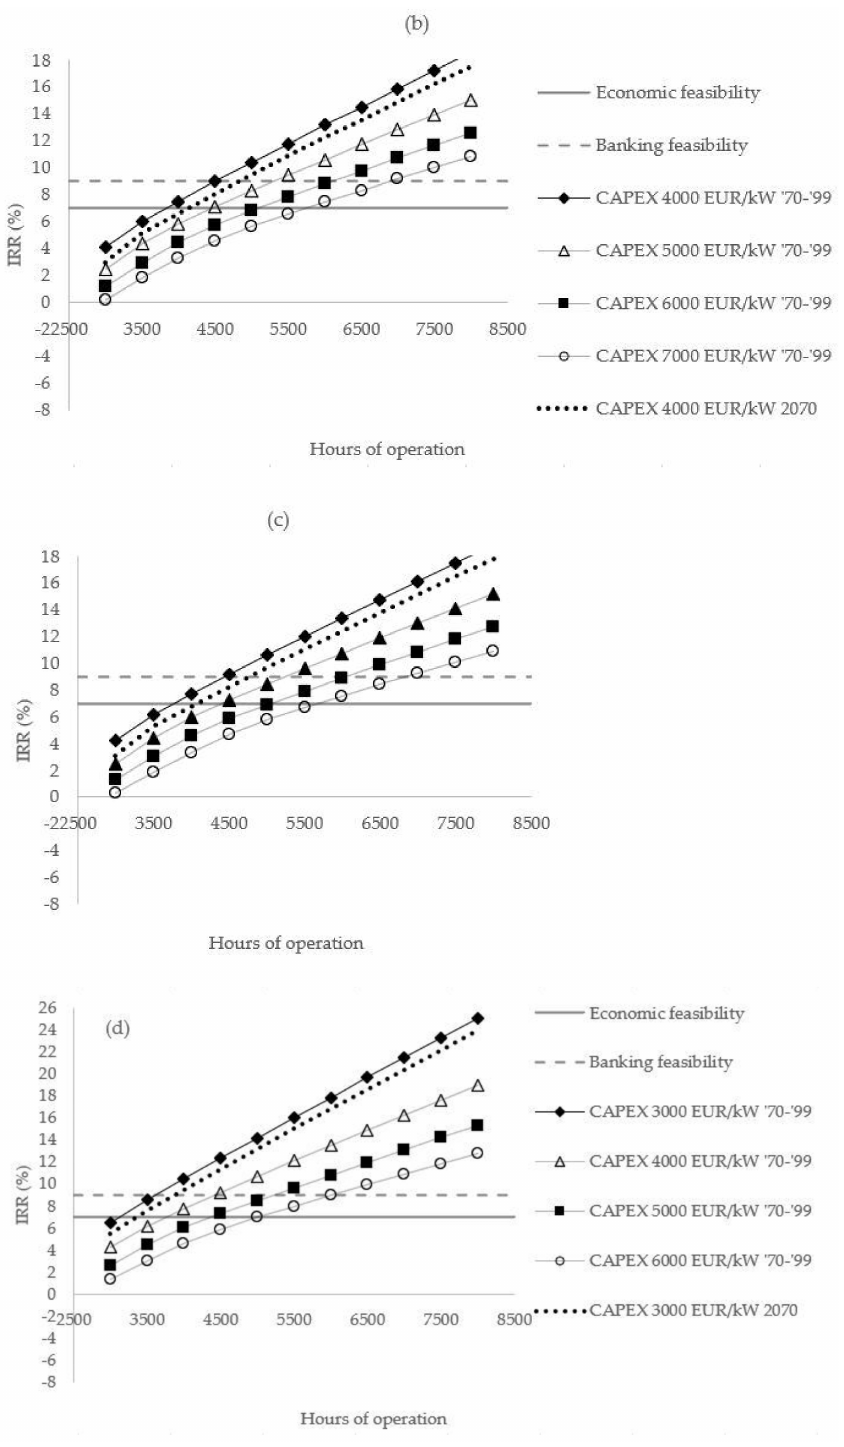
Figure 12. Internal rate of return vs. hours of operation, comparing scenarios 2070–2099, for Approach 1 and Approach 2: 100 kW ( a ), 250 kW ( b ), 500 kW ( c ), 1000 kW ( d